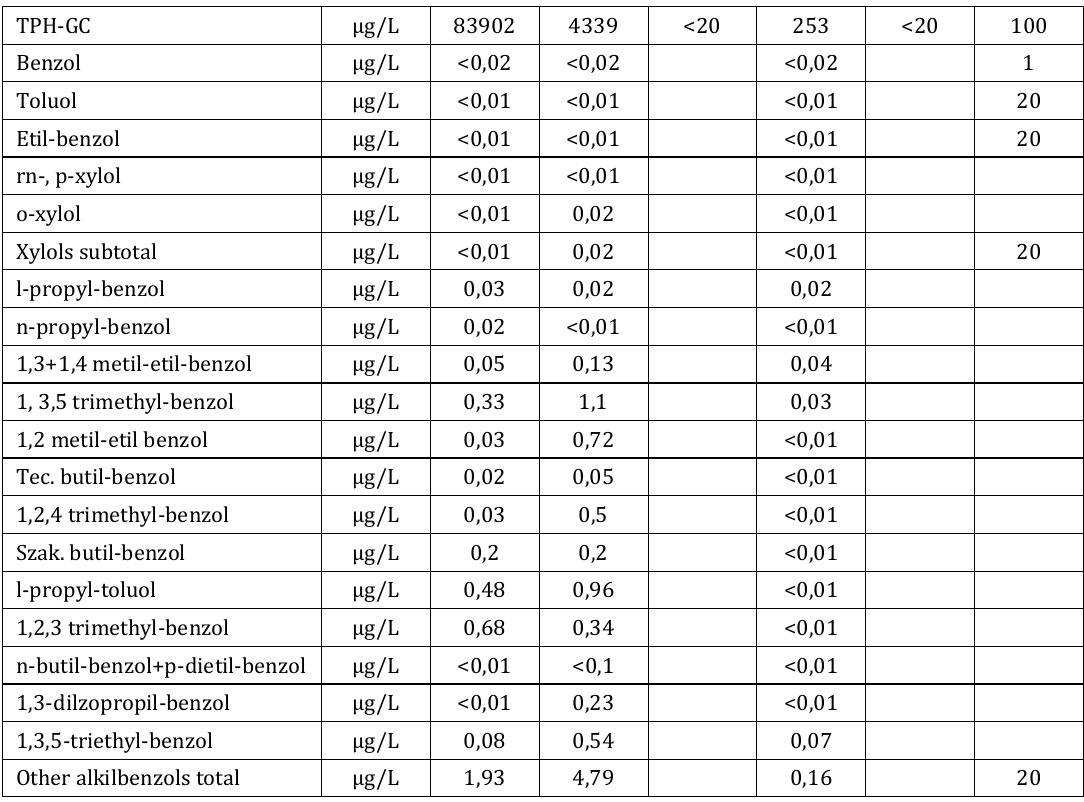
Table 5. Excerpt containing the result of the ground-water samples (Source: author’s edit, 2019) based on the results of